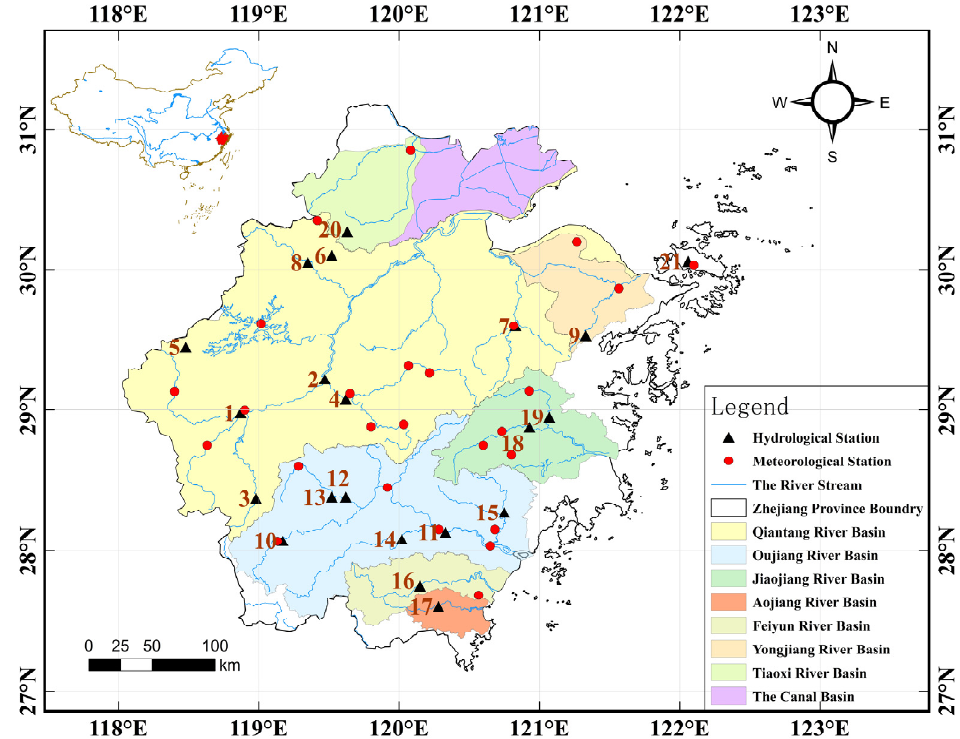
Figure 2. Location of the study area showing different basins and hydrometeorological stations.